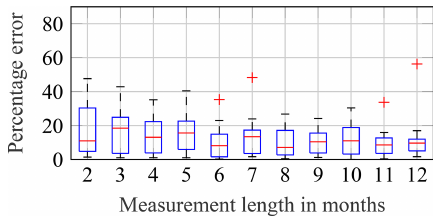
Figure 24. Convergence of the percentage error of predicted yearly damage values using the ANN for increasing measurement lengths. Box plot shows data from 13 different measurement periods.